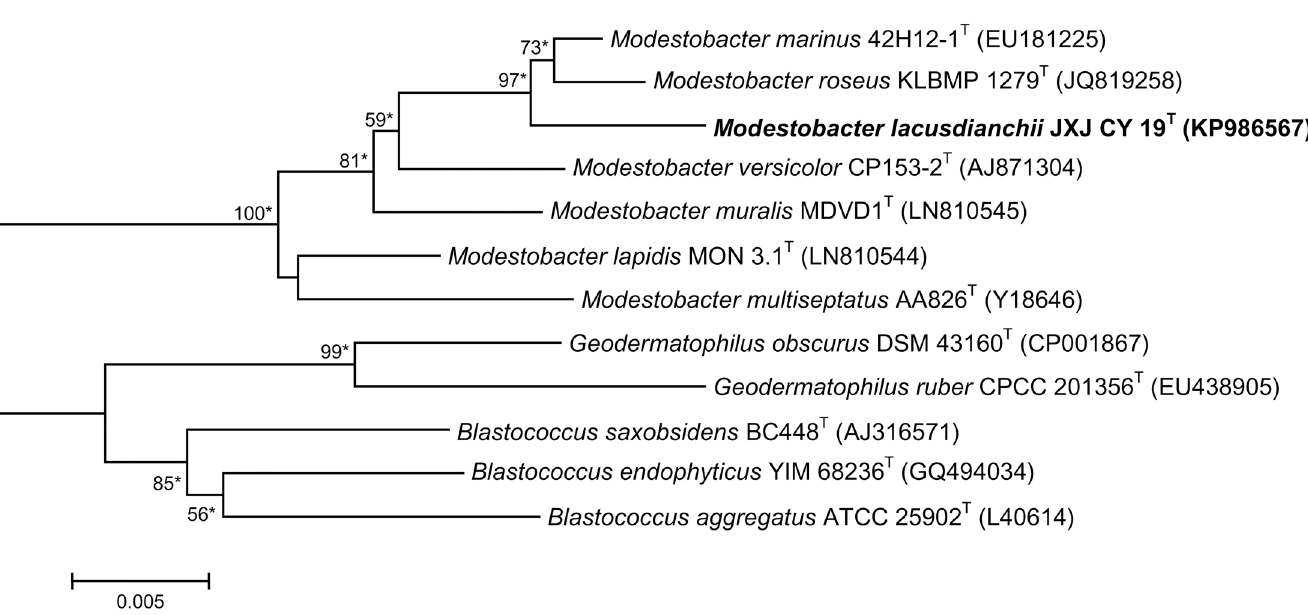
Fig 1. Neighbour-joining phylogenetic tree based on 16S rRNA gene sequences of strain JXJ CY 19 T and representative type strains of the family Geodermatophilaceae . Bootstrap values (expressed as percentages of 1,000 replications) of above 50% are shown at the nodes. Asterisks indicate clades that were conserved using the maximum-parsimony and maximum-likelihood methods. Bar, 0.005 sequence